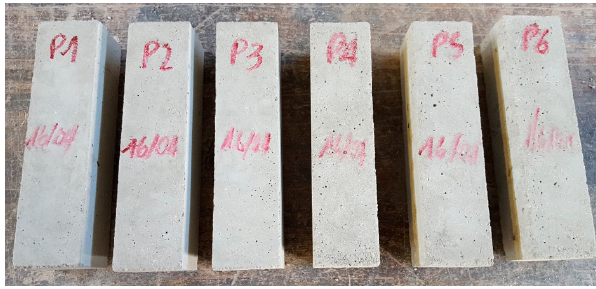
Figure 32. The six specimens for three-point bending flexural tests on mortar. Table 2. Geometric and mechanical characteristics of the mortar specimens.